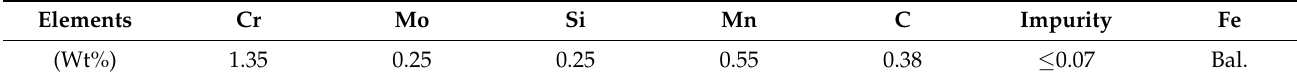
Table 1. Chemical composition of the 40CrMo steel used in this study.